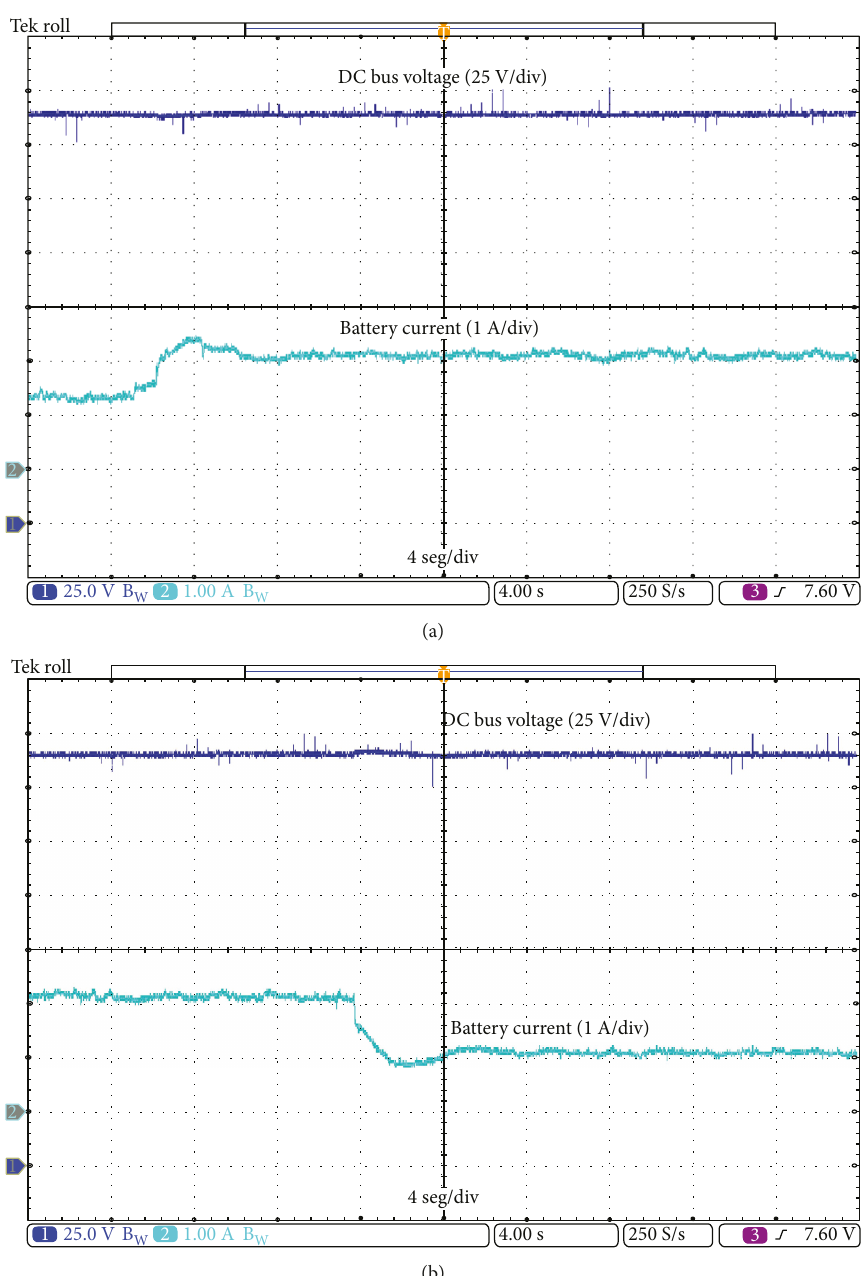
Figure 12: (a) Connection of the DC bus to the laptop and (b) disconnection of the DC bus from the